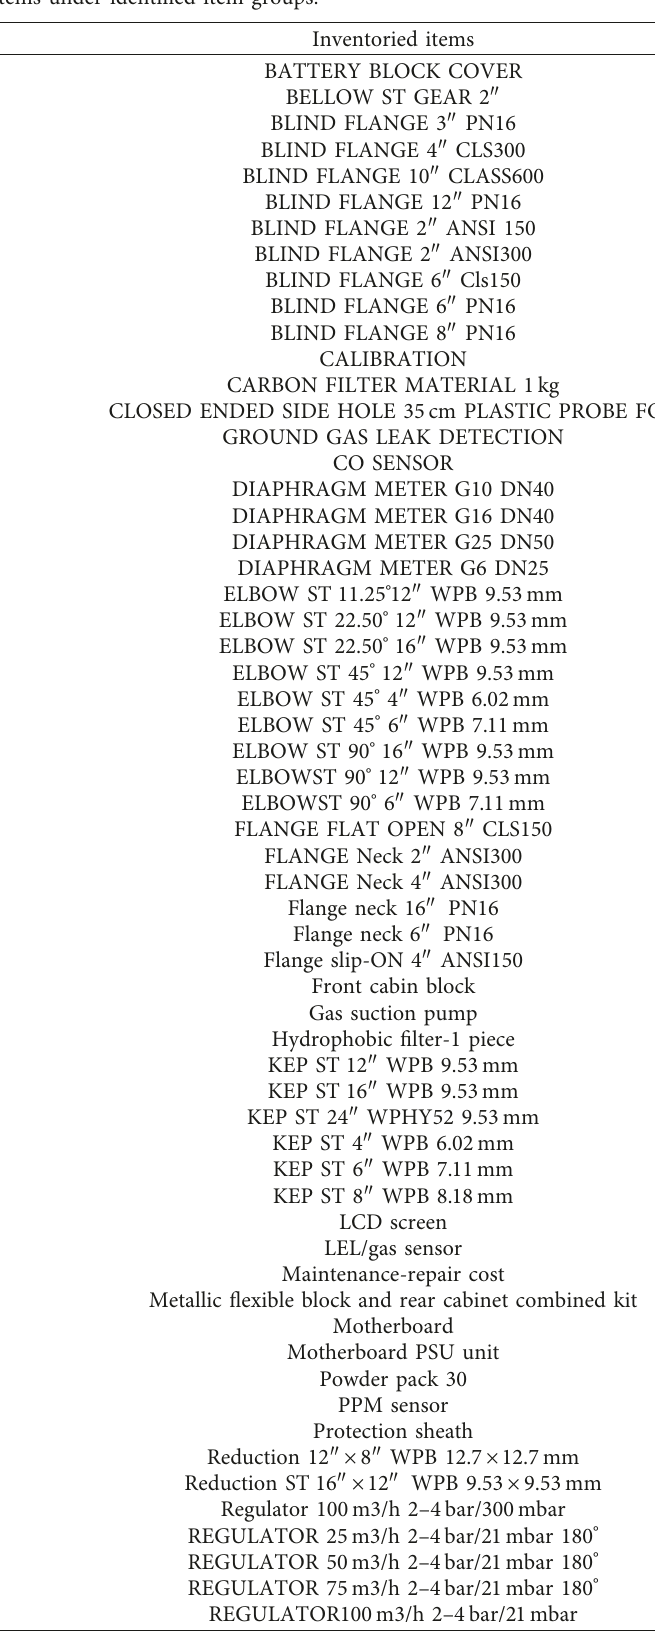
Table 7: Category I items under identified item